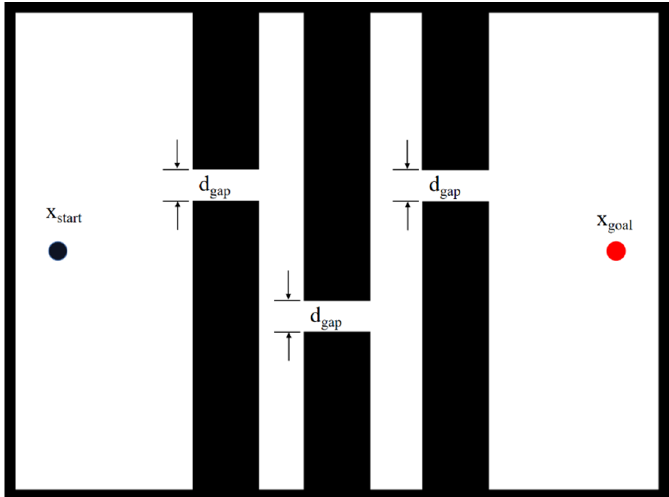
Figure 10. Schematic illustration of simulation environment 2, where three narrow passages are required from the starting state 𝑥 (cid:3046)(cid:3047)(cid:3028)(cid:3045)(cid:3047) to the goal state 𝑥_𝑔𝑜𝑎𝑙 . The distance from the state 𝑥 (cid:3046)(cid:3047)(cid:3028)(cid:3045)(cid:3047) to the target state 𝑥 (cid:3034)(cid:3042)(cid:3028)(cid:3039) is 𝑑 (cid:3034)(cid:3042)(cid:3028)(cid:3039) . The value is set to